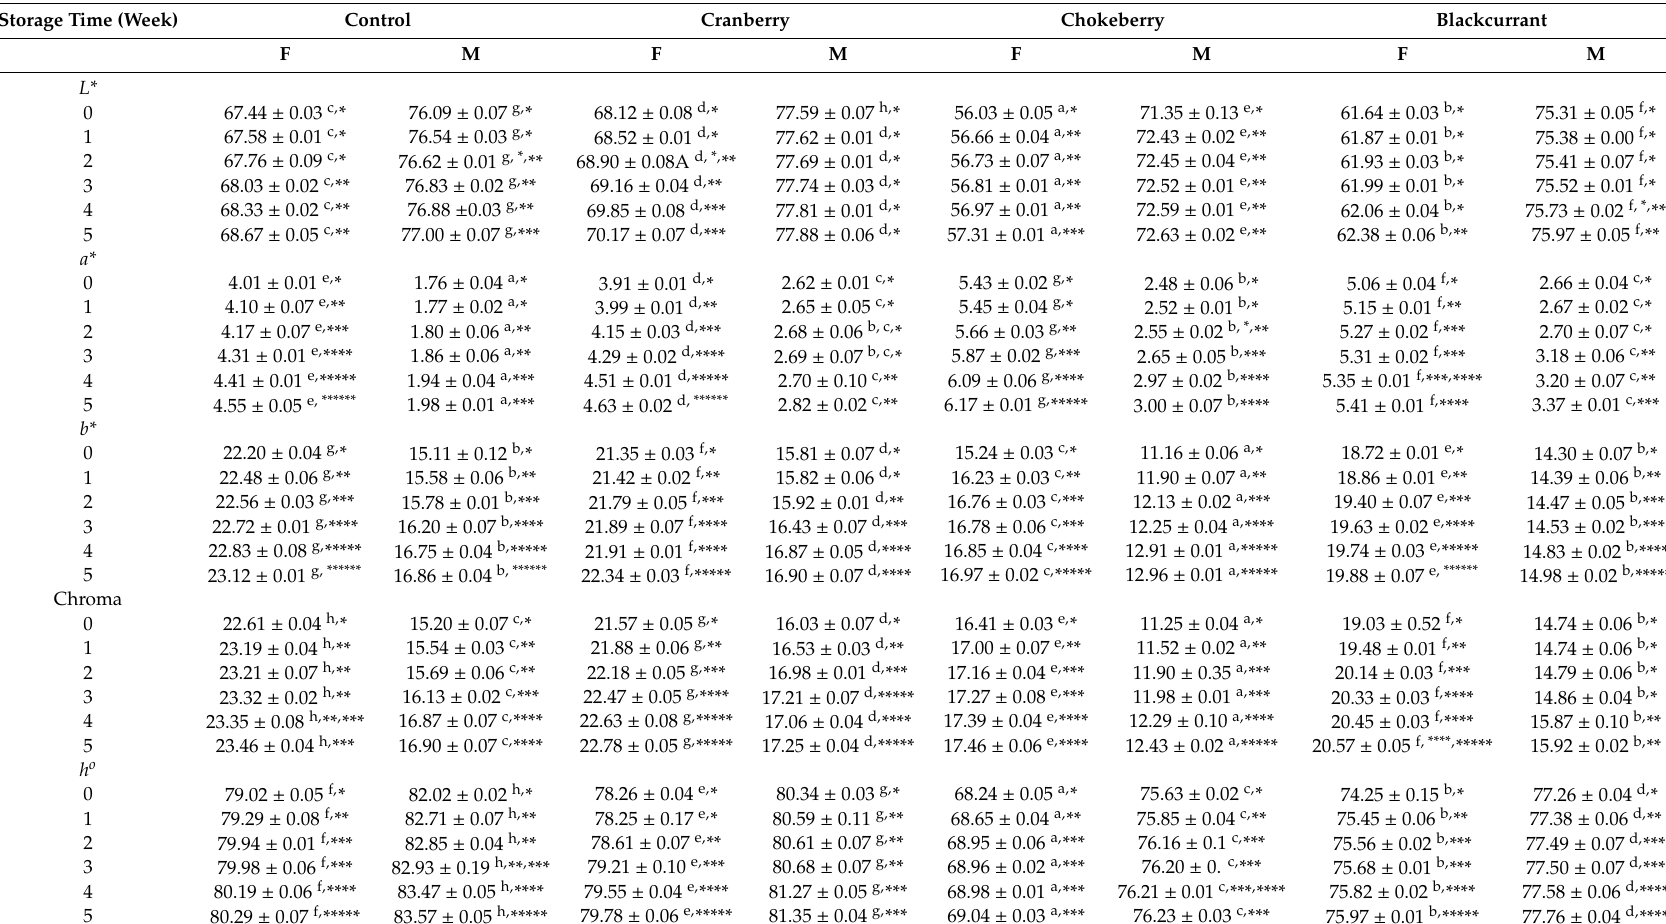
Table 2. Colour ( L , a* , b* , C , h ◦ ) and browning index of fried and microwaved snacks made from Jerusalem artichoke flour with addition of fruit powders during storage for 5